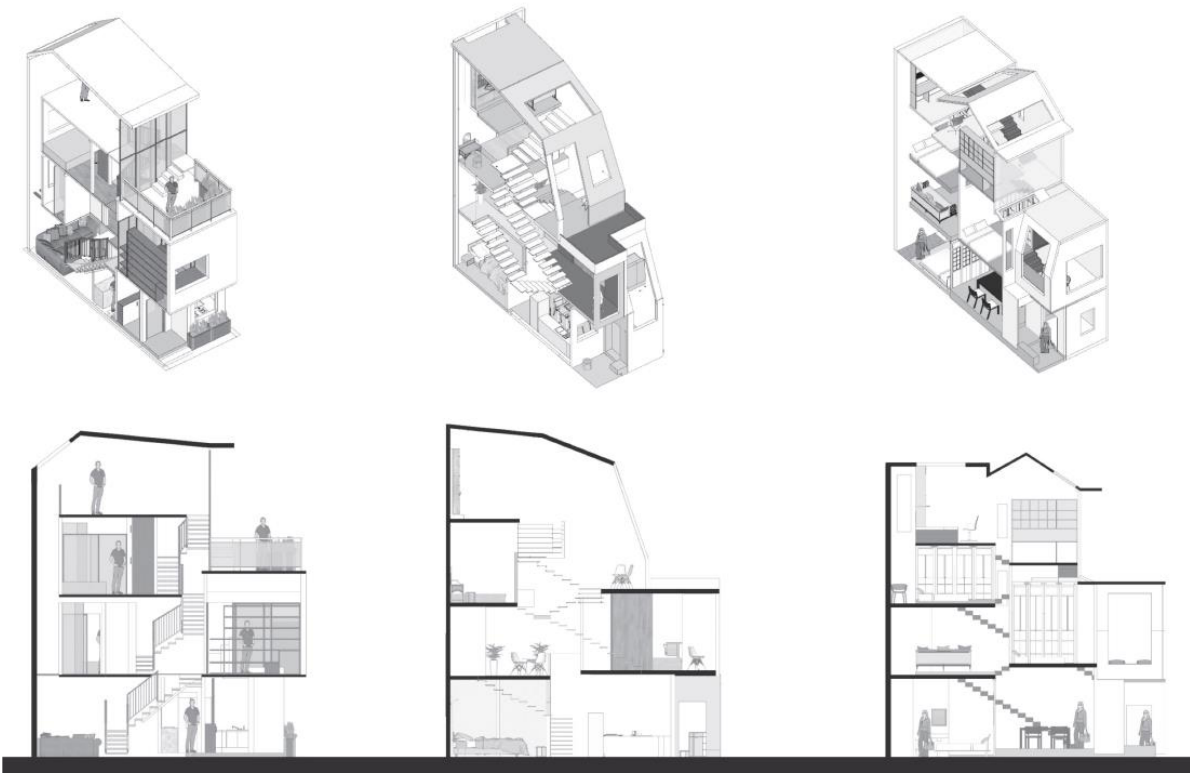
Figure 19. Different concept design models (drawn by the students).